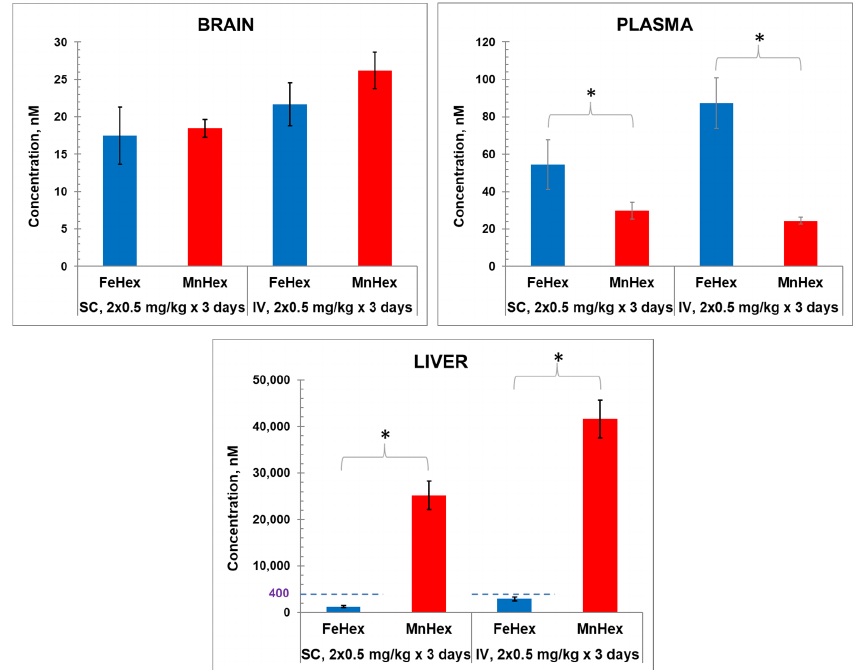
Figure 4. The 3-day mouse PK study. MnHex and FeHex were given twice daily to healthy mice via two administration routes: SC at 0.5 mg/kg and IV at 0.5 mg/kg. Three mice were analyzed per data point and per compound. Mice were sacrificed 6 h after last injection, at which point plasma and tissues were analyzed. Error bars depict single standard deviation. Brain SC, FeHex vs MnHex, p = 0.728; Brain IV FeHex vs MnHex, p = 0.275; Plasma SC FeHex vs MnHex, p = 0.042; Plasma IV, FeHex vs MnHex, p = 0.019; Liver SC, FeHex (126 nm) vs MnHex, p = 0.005; Liver IV, FeHex (290 nm) vs MnHex, p = 0.003 . Please note different scale (in blue) for FeHex bars in “Liver” plot. The “star” (*) symbol denotes statistically significant difference ( p < 0.05).